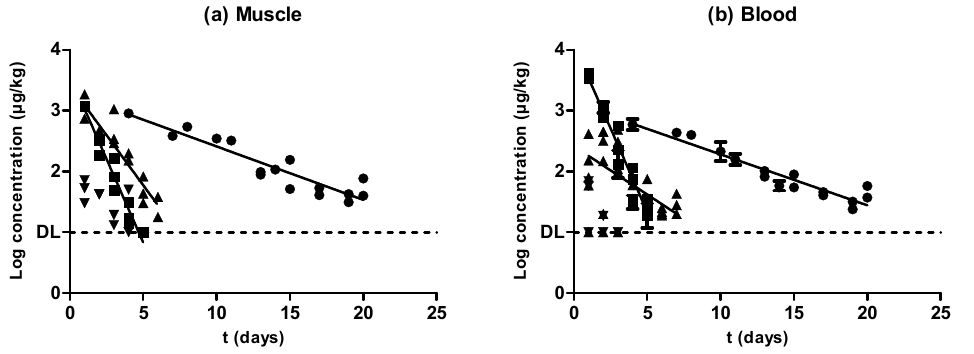
Comparison between the rate of elimination described for oxytetracycline ( • ), sulfamethoxypyridazine ( ), enrofloxacin ( ▲ ), and amoxicillin ( ▼ ) in muscle ( a ) and blood ( b ) samples.